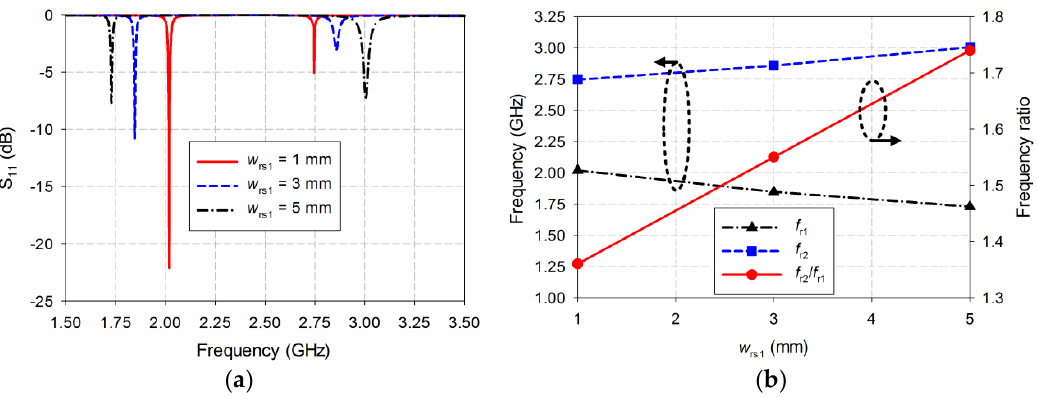
Figure 3. ( a ) S 11 characteristics of the slot-loaded patch antenna in Figure 1b for varying slot widths w rs1 ; ( b ) the first and second resonant frequencies, and the frequency ratio vs. w rs1